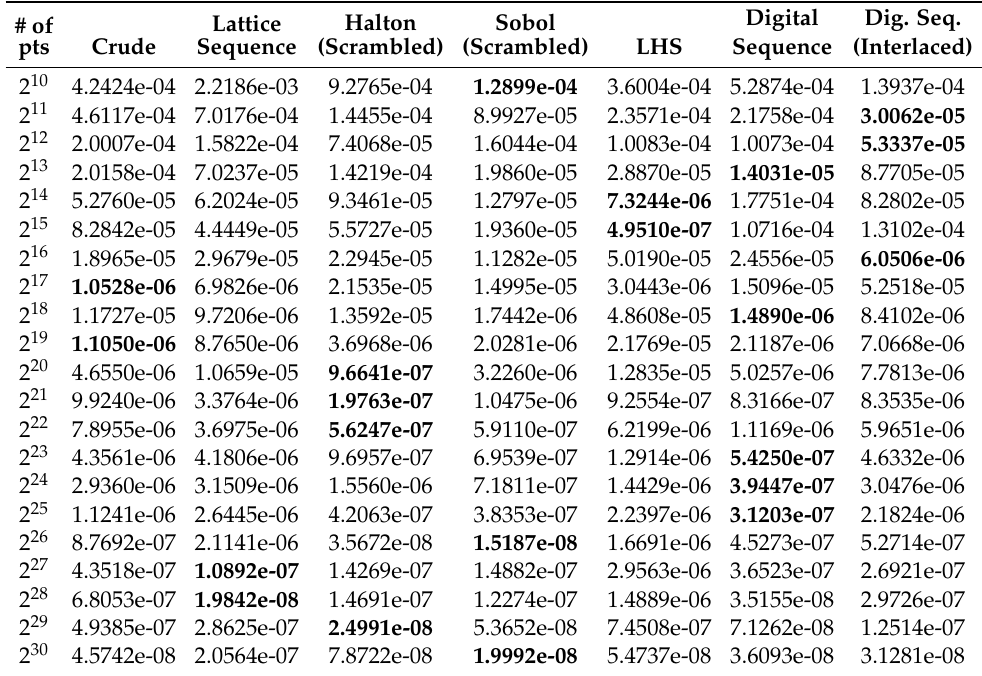
Table 2. The 20-dimensional integral absolute errors.